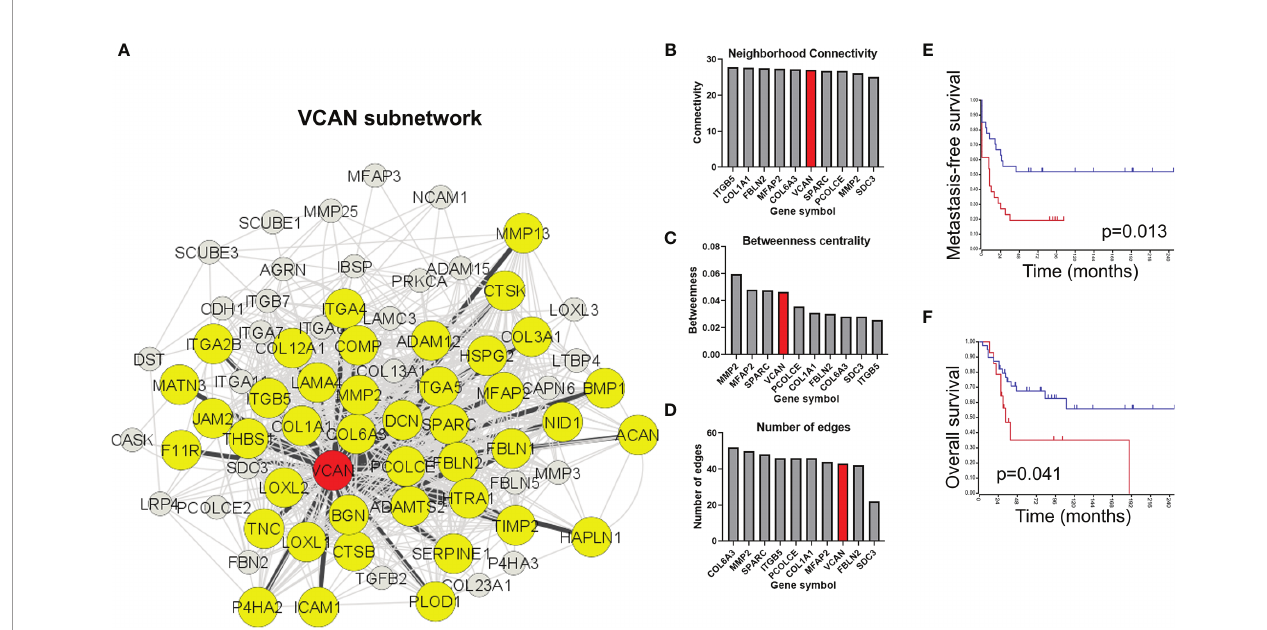
FIGURE 4 | Versican-mediated extracellular matrix organization is enriched in extravasated circulating tumor cells. (A) Versican is commonly upregulated in both cell lines and interacts with a core subset of the extracellular matrix organization pathway. Yellow nodes indicate proteins that share at least one interaction with versican. (B) Ranking of top nodes based on neighborhood connectivity, (C) betweenness centrality, and (D) number of edges in the extracellular matrix remodeling pathway. Prognostic value of VCAN for (E) metastasis-free survival and (F) overall survival in osteosarcoma